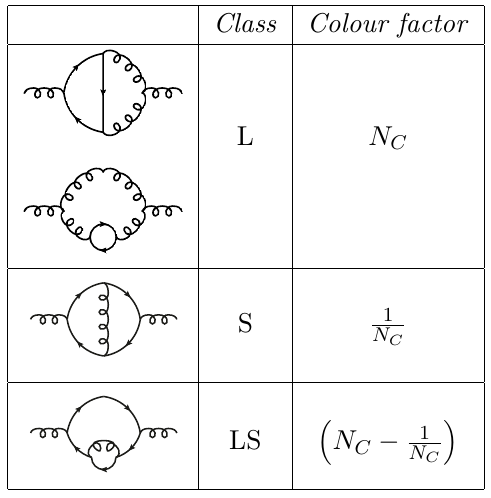
Table 1. The classification of diagrams in colour structures follows that of the two-loop gluon self-energy diagrams involving a closed fermion loop. This motivates splitting the amplitude into leading and sub-leading colour.